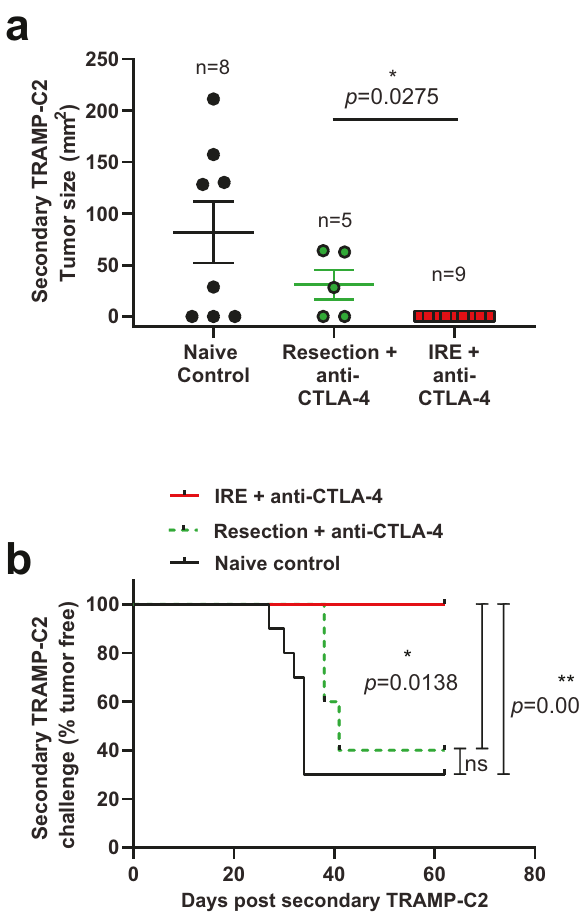
Fig. 8 IRE plus anti-CTLA-4 combination therapy is associated with protection from secondary tumor challenge. TRAMP-C2 tumors were inoculated into the right fl ank of C57BL/6J mice and allowed to grow to ~4 – 5 mm diameter. Tumors were removed by IRE or surgical resection, followed by treatment with four doses of anti-CTLA-4. Tumor-free mice were selected and rested for three additional weeks when mice were re- challenged in the left fl ank with 1.0 × 10 6 TRAMP-C2 cells. a Tumor size 42 days after secondary tumor challenge, with exact n values shown and data points re fl ecting independent biological replicate mice. Age-matched naive mice were used as a control, demonstrating typical ~60 – 70% tumor “ take ” rate. Bars represent mean ± SEM. Unpaired two-tailed Mann – Whitney test was performed; * p < 0.05. b Kaplan – Meier curves from the mice in ( a ), noting the day of tumor incidence following secondary tumor challenge. Two-sided Mantel-Cox log rank test was performed; * p